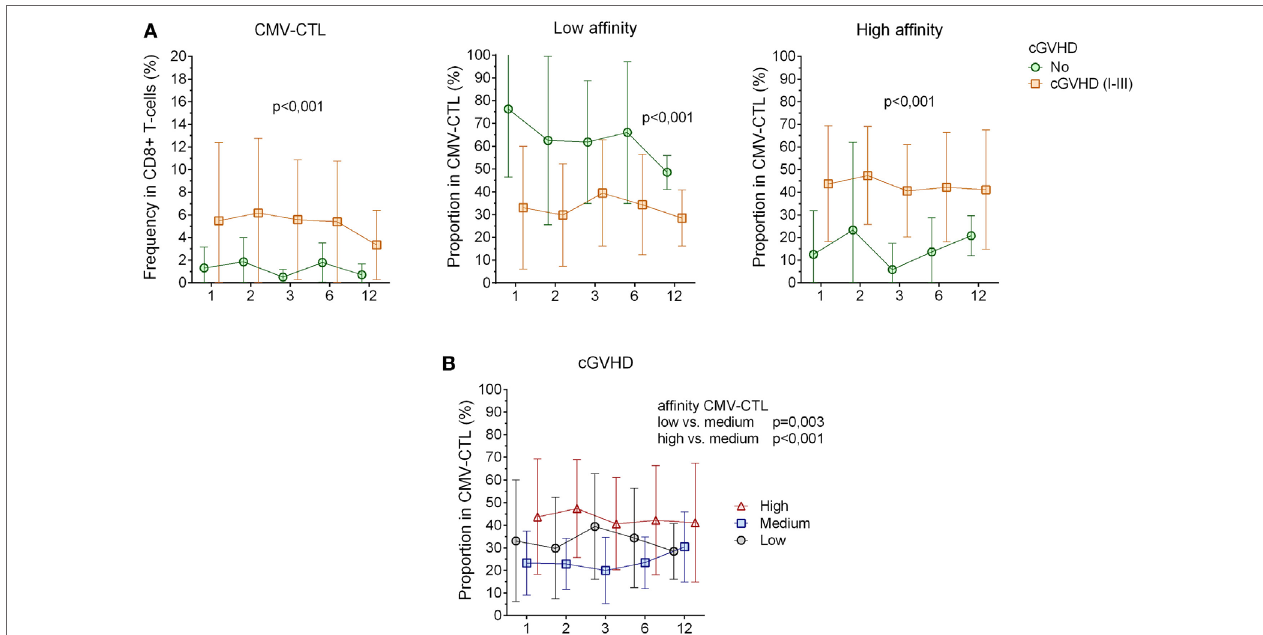
FigUre 4 | Correlation between cytomegalovirus(CMV)-specific CD8 + cytotoxic T-lymphocytes(CTL) affinity and cgraft-versus-host disease(GVHD). (a) CMV-CTL frequency, low and high-affinity proportion correlated with cGVHD. Green circle: no cGVHD, orange square: cGVHD (I–III) (b) Proportion of high/medium/low-affinity CMV-CTL in patients presenting clinical symptoms of cGVHD (I–III). Black circles: low-affinity CMV-CTL, blue squares: medium-affinity CMV-CTL, red triangles: high-affinity CMV-CTL. Mean and SD are represented. Two-way ANOVA was used to detect differences between two groups over